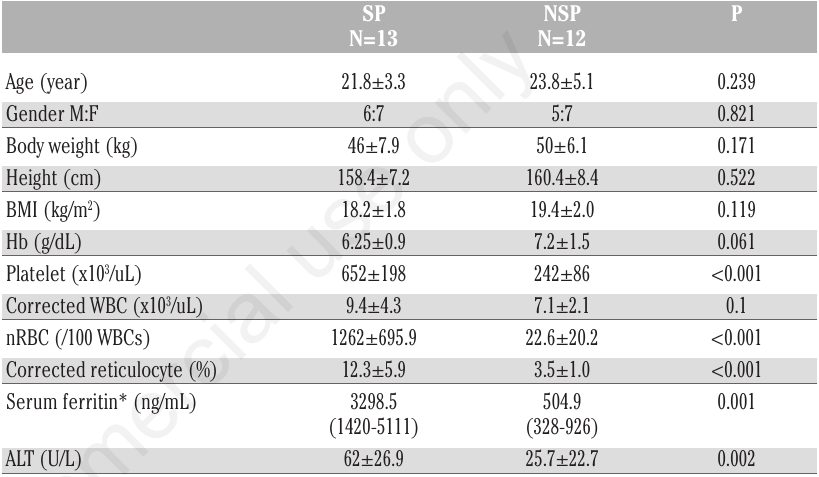
Table 1. Characteristics of E/ β -thalassemia patients with and without splenectomy (data are expressed as mean ± SD).